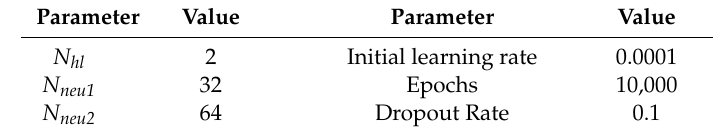
Table 6. The BP neural network parameters.